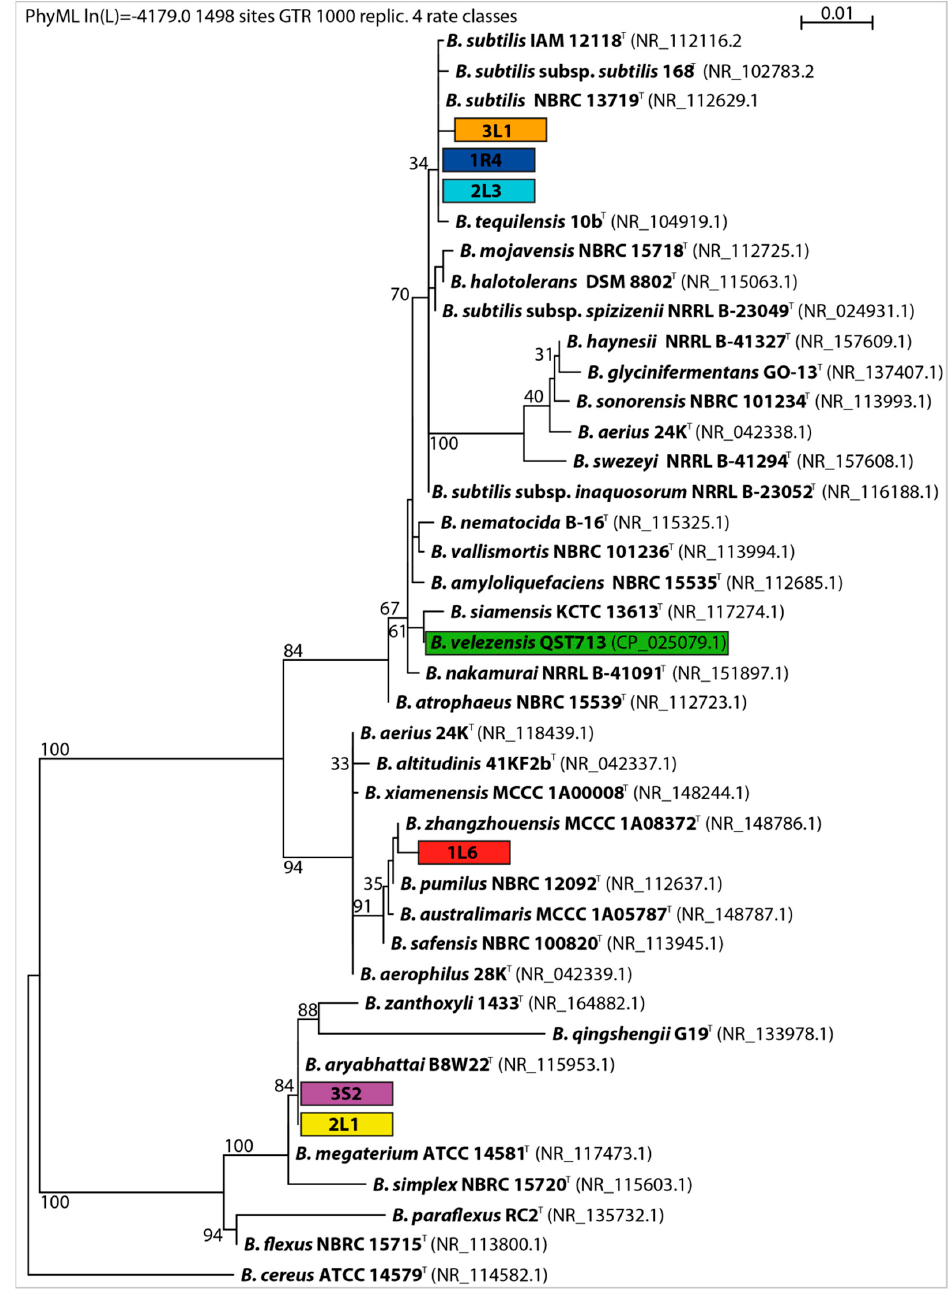
Figure 1. Maximum likelihood phylogenetic tree of Bacillus spp. isolates used in PGP trait analysis. Tree was generated using the GTR model, BioNJ starting tree, optimized nucleotide frequencies, and best of NNI and SPR tree searching, followed by 1000 bootstraps. Numbers above branches are bootstrap values.